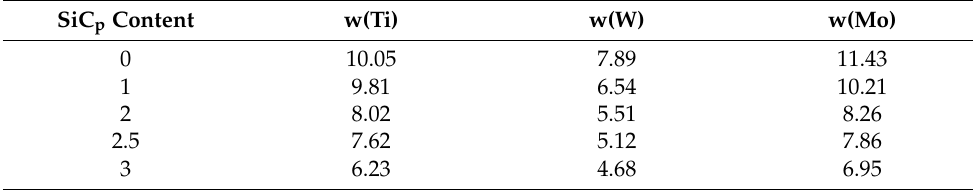
Figure 2. ( a ) Typical XRD patterns of the as-prepared Ti(C,N)-based cermets with various amounts of SiC p . ( b ) Effect of SiC p content on the lattice parameter of hard phase and binder phase. Table 2. Effect of SiC p content on composition of the binder (wt.%).